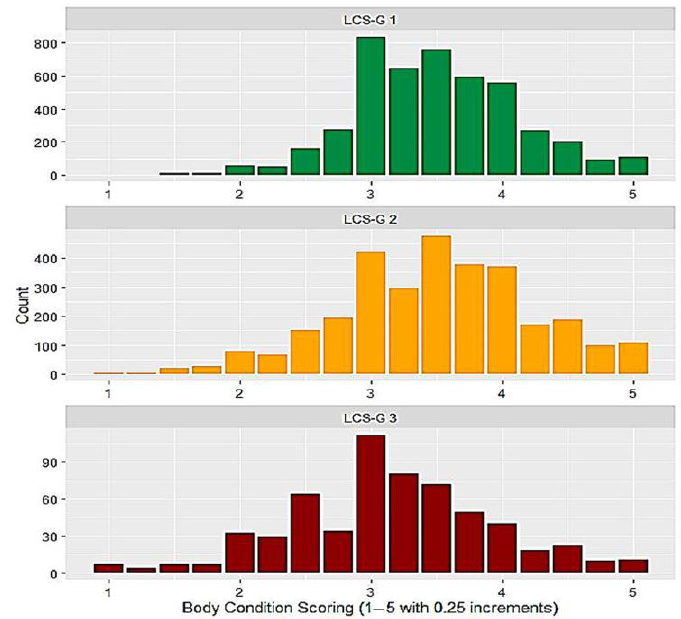
Figure 1. Distribution of body condition scores according to LCS-G 1–3; LCS-G 1–3: locomotion score groups 1 to 3.